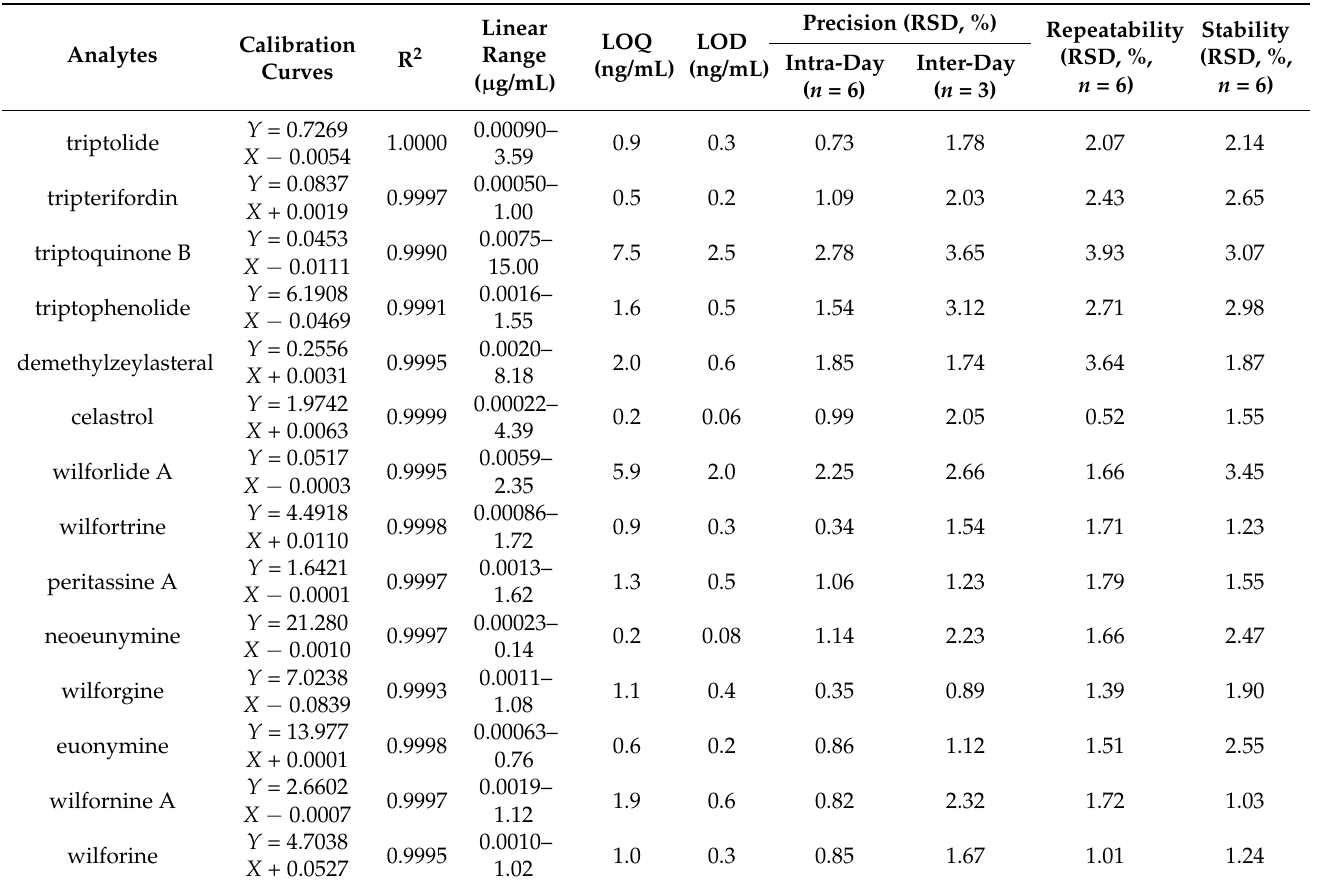
Table 3. Calibration curves, limit of detection (LOD), limit of quantification (LOQ), precision, repeata- bility, and stability for the 14